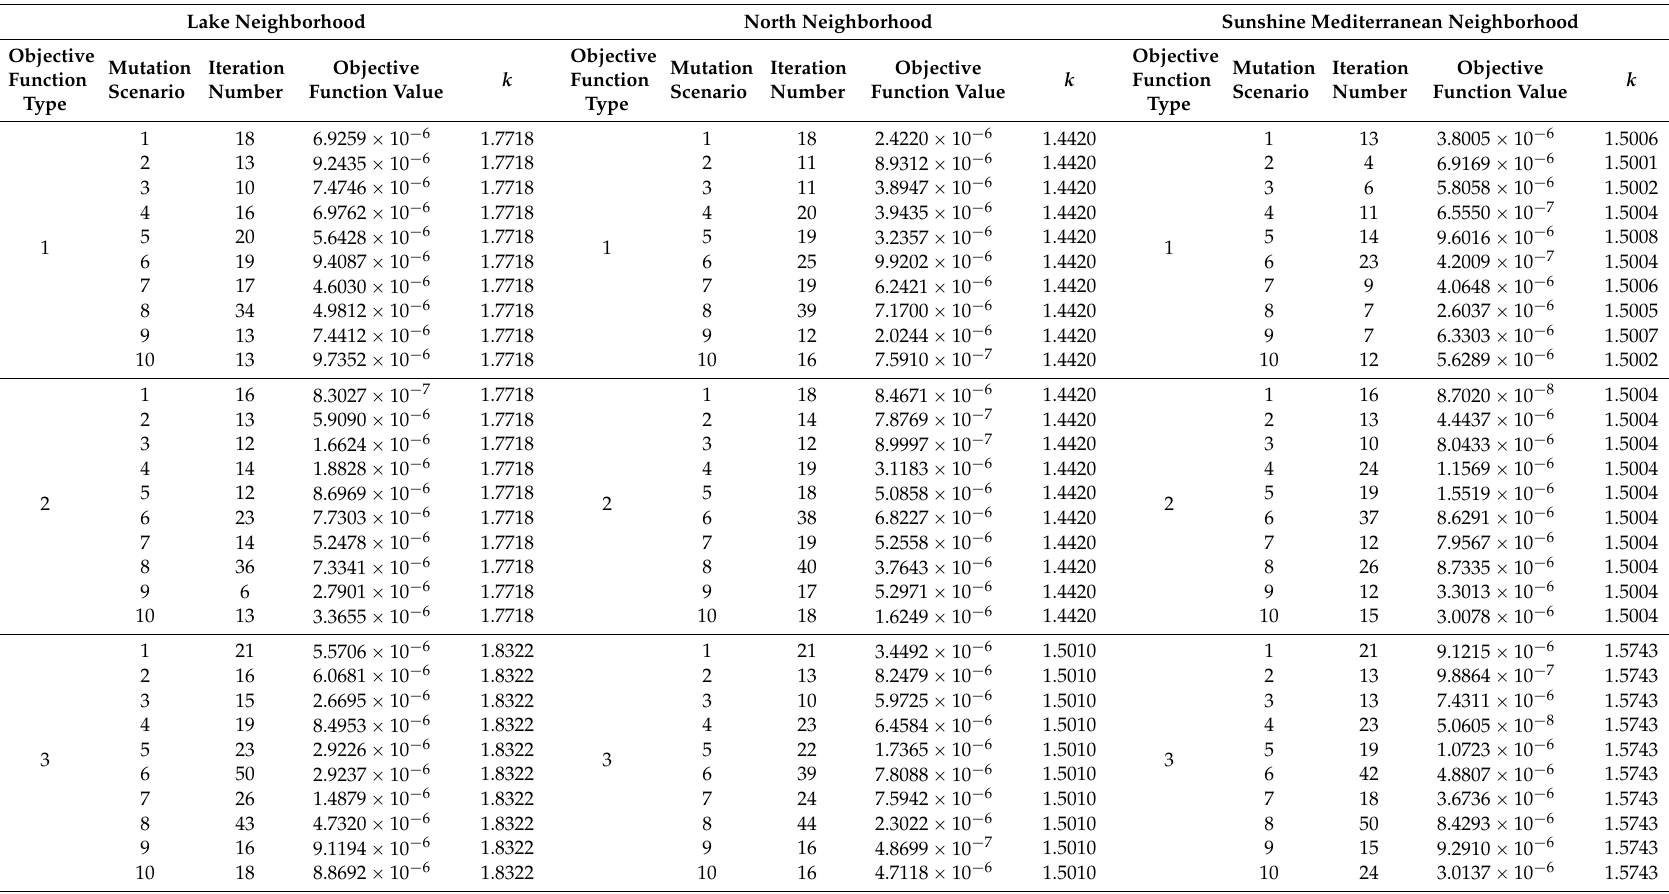
Table 1. Parameters obtained by three different objective